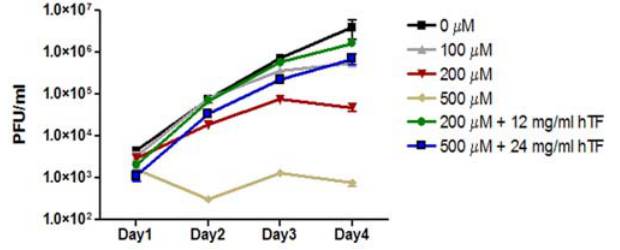
Figure 4. Growth of R.rickettsii under limiting iron conditions. A) R. rickettsii was grown on monolayers of Vero cells with increasing concentrations of deferozamine mesylate (0, 100, 200, and 500 m M) and PFUs were determined for days 1, 2, 3, and 4 after infection. To determine if the effects of high concentrations of deferozamine mesylate (200 and 500 m M) were reversible excess iron saturated holotransferrin (12 and 24 mg/ml respectively) was added to the media as an iron